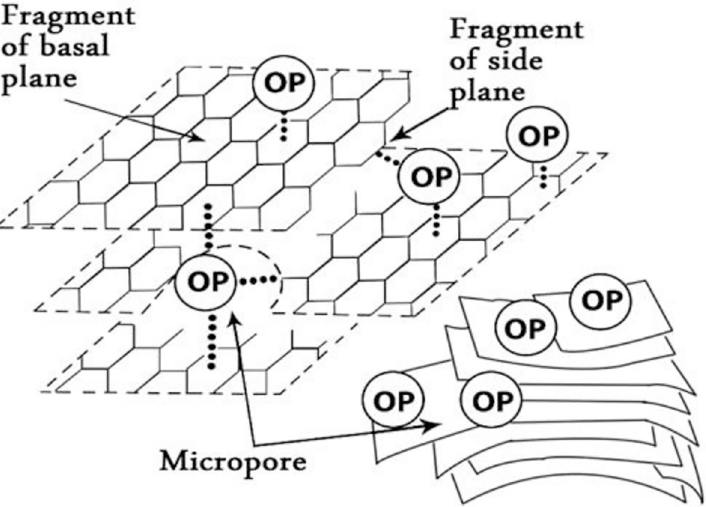
Fig 11. Types of adsorption sites that occur on activated carbon: Basal plane, edge plane, and micropores.